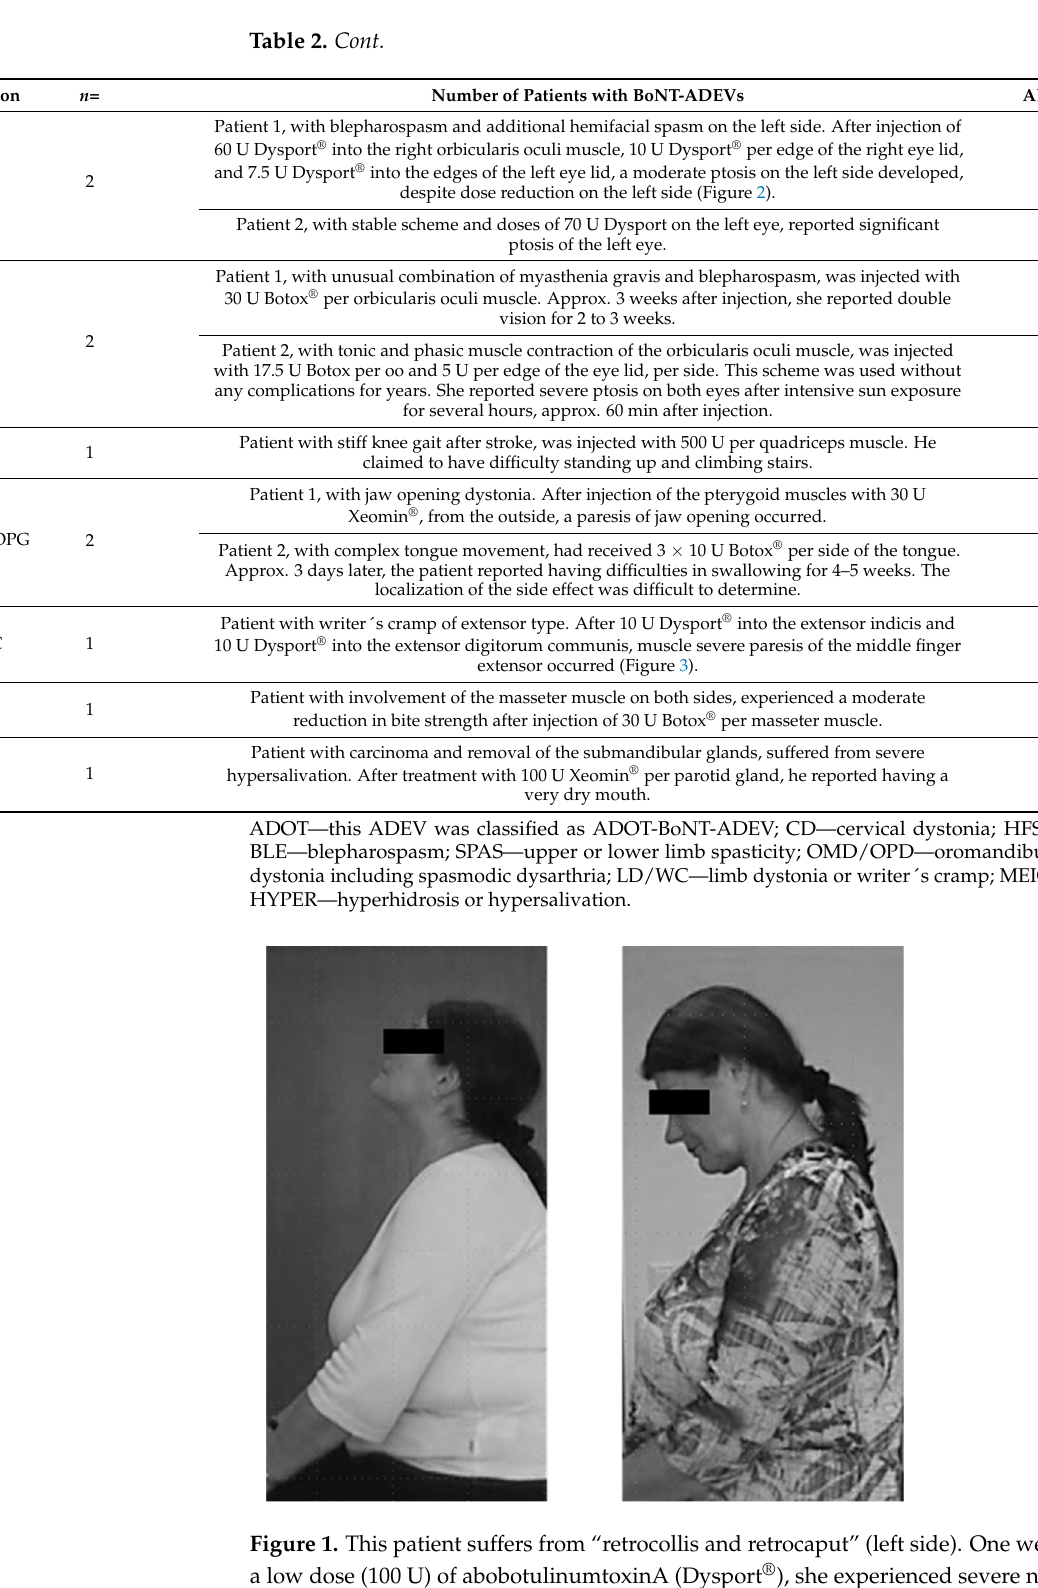
Figure 2. This patient suffers from an extremely rare combination of a blepharospasm with eye- opening dystonia, and an additional hemifacial spasm on the left side. Although the dose used for the left eye was highly reduced to 20% of the dose used for the right eye, a ptosis of the left eye occurred.